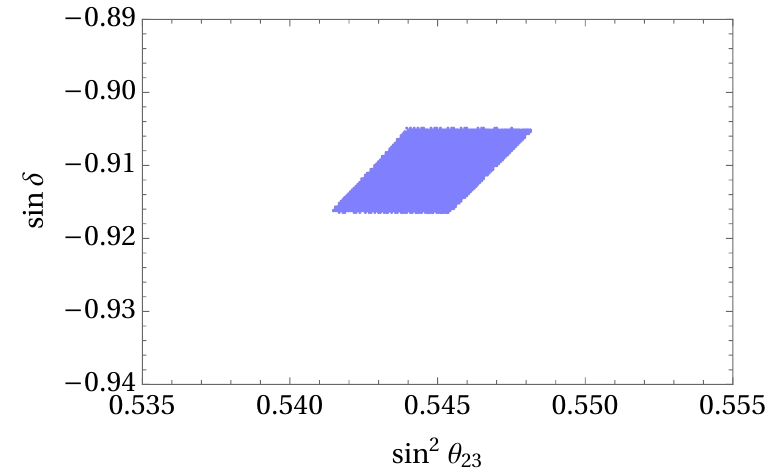
Figure 3 . The predicted ranges of sin 2 (cid:18) 23 and sin (cid:14) as constrained by the parameters (cid:20) s and (cid:20) a .